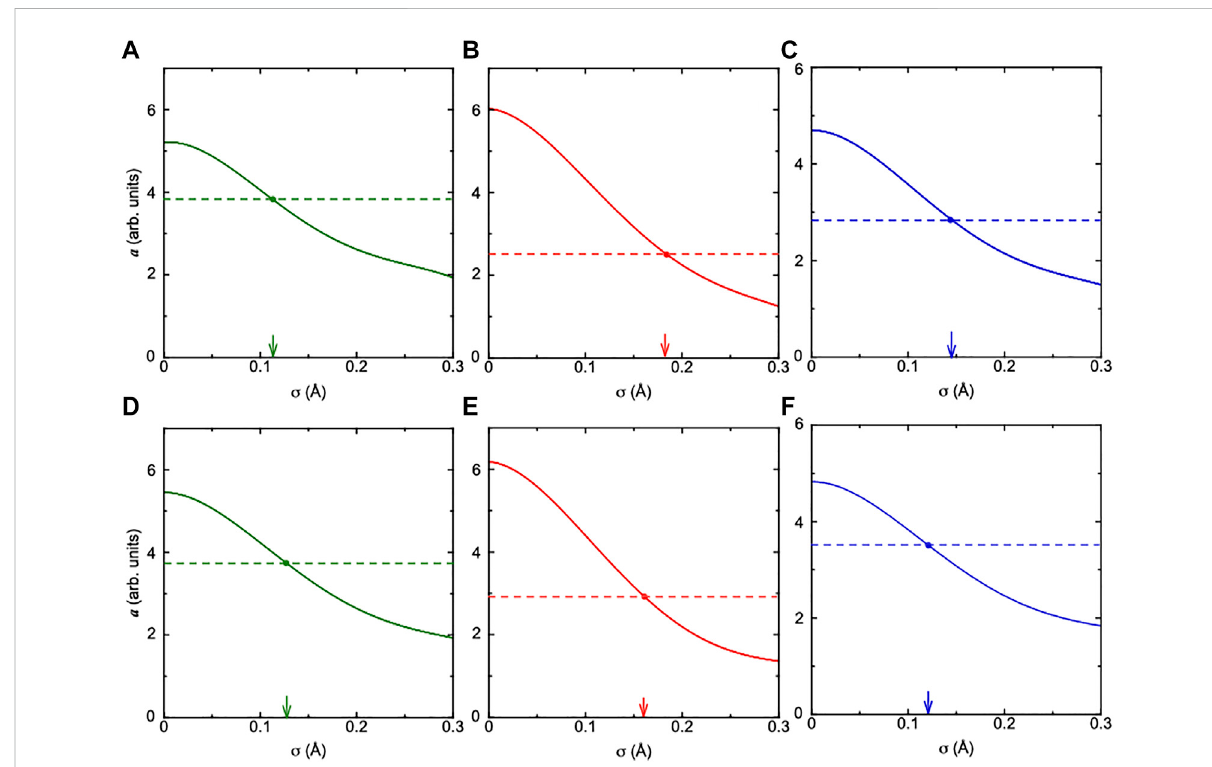
FIGURE 8 Calculated a values for Ca (green), Ta (red), and Ga (Ga/Al) (blue) atoms in CTGS (A,B,C) and CTGAS (D,E,F) , plotted as a function of the atomic displacement σ . Filled circles indicate a values obtained from Figure